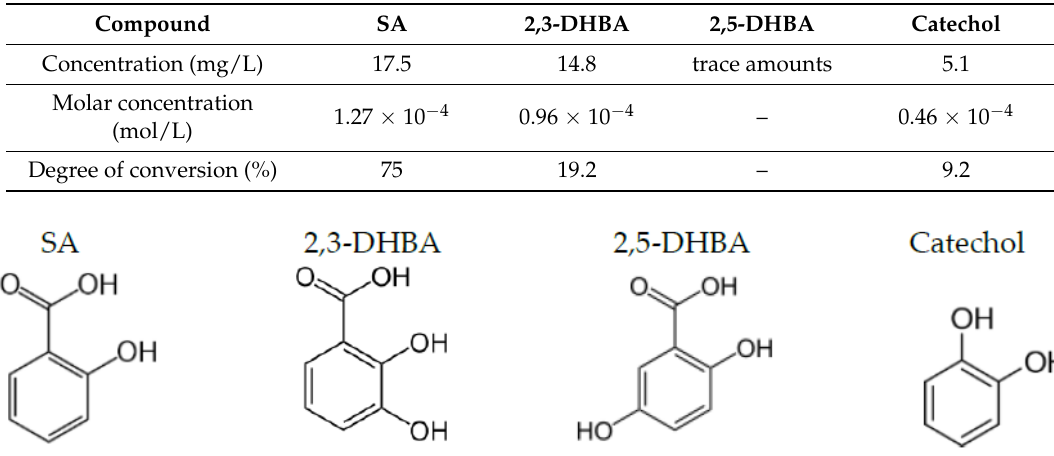
Table 3. Concentrations of salicylic acid and its oxidation products after 60 min of oxidation with UV/H 2 O 2 ;